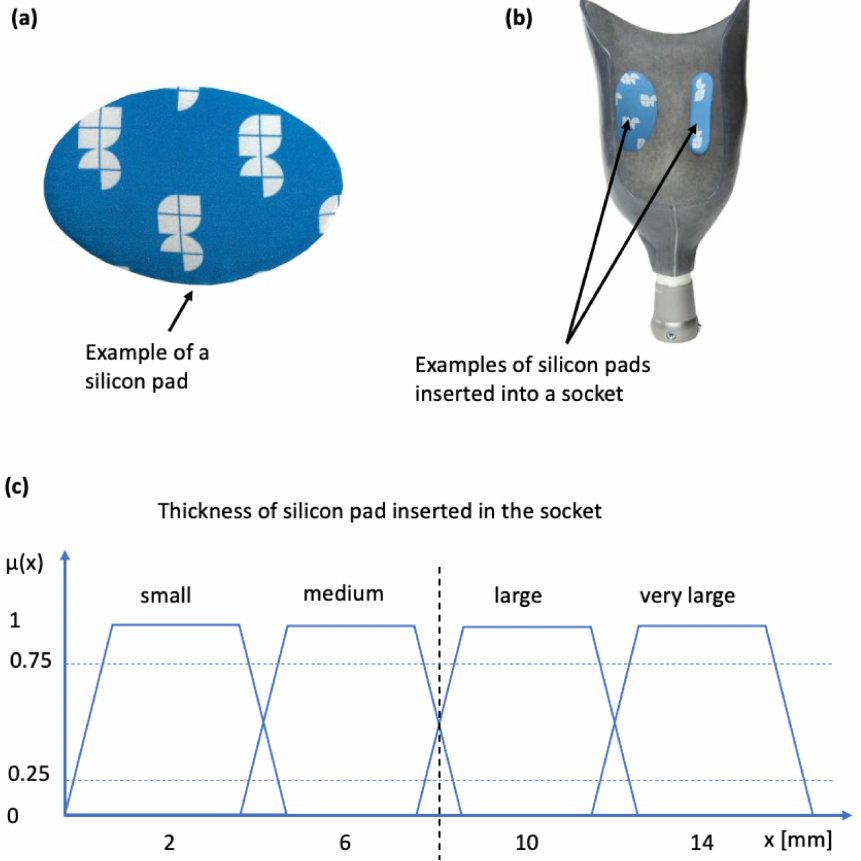
Figure 4. Silicon pads for socket rectification and associated membership function: ( a ) silicon pad; ( b ) silicon pad inserted into the inner wall of the socket (sticks due to adhesives); ( c ) membership function connecting the linguistic variable to pad